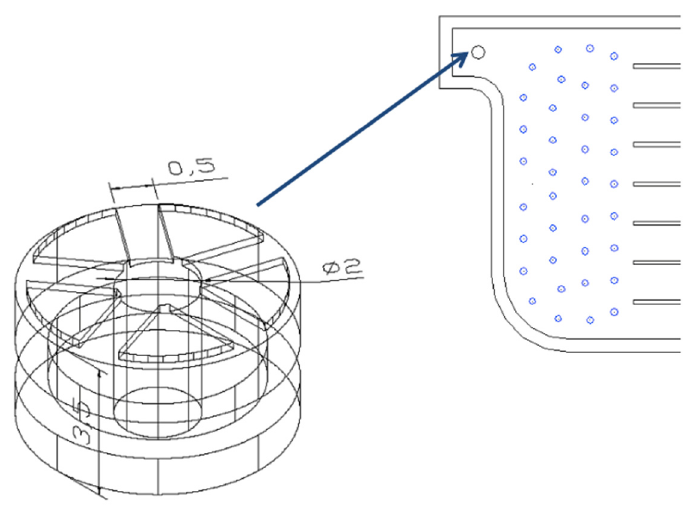
Figure 4. Diagram of the 0.5 mm acrylic insert displaying the location of insertion in the reactor.